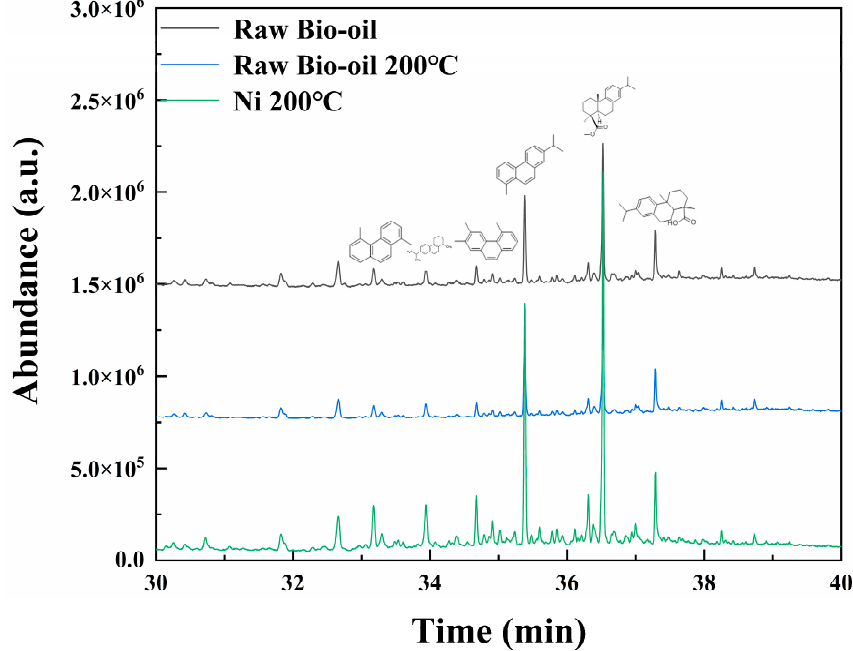
Figure 13. GC-MS results of raw bio-oil and bio-oil Pickering emulsion hydrodeoxygenation products at 200 °C.